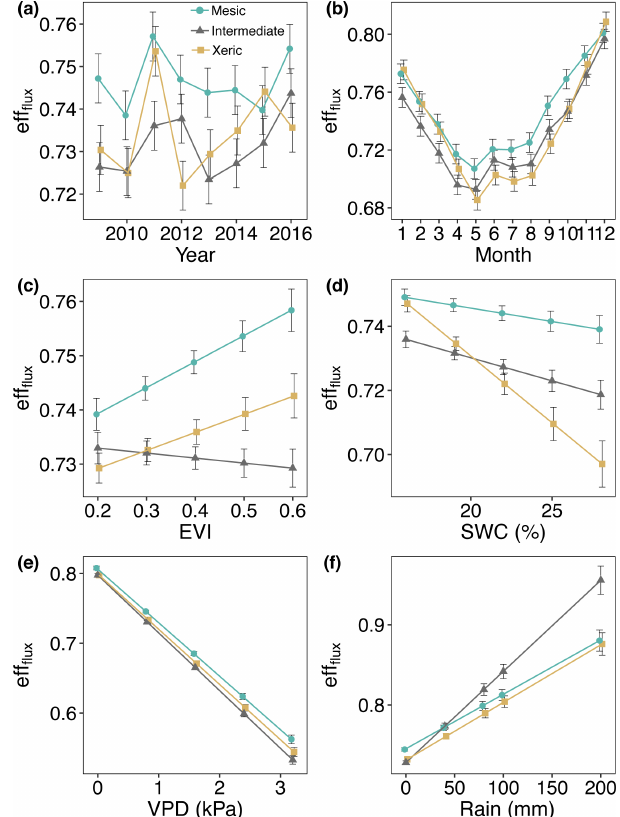
Figure 9. Least squares mean predicted values from mixed mod- els of average daily half-hourly flux entropy efficiencies (eff flux ) at the mesic, intermediate and xeric sites by (a) year, (b) month, (c) enhanced vegetation index (EVI), (d) soil water content (SWC), (e) vapor pressure deficit (VPD) and (f) rain. Error bars represent